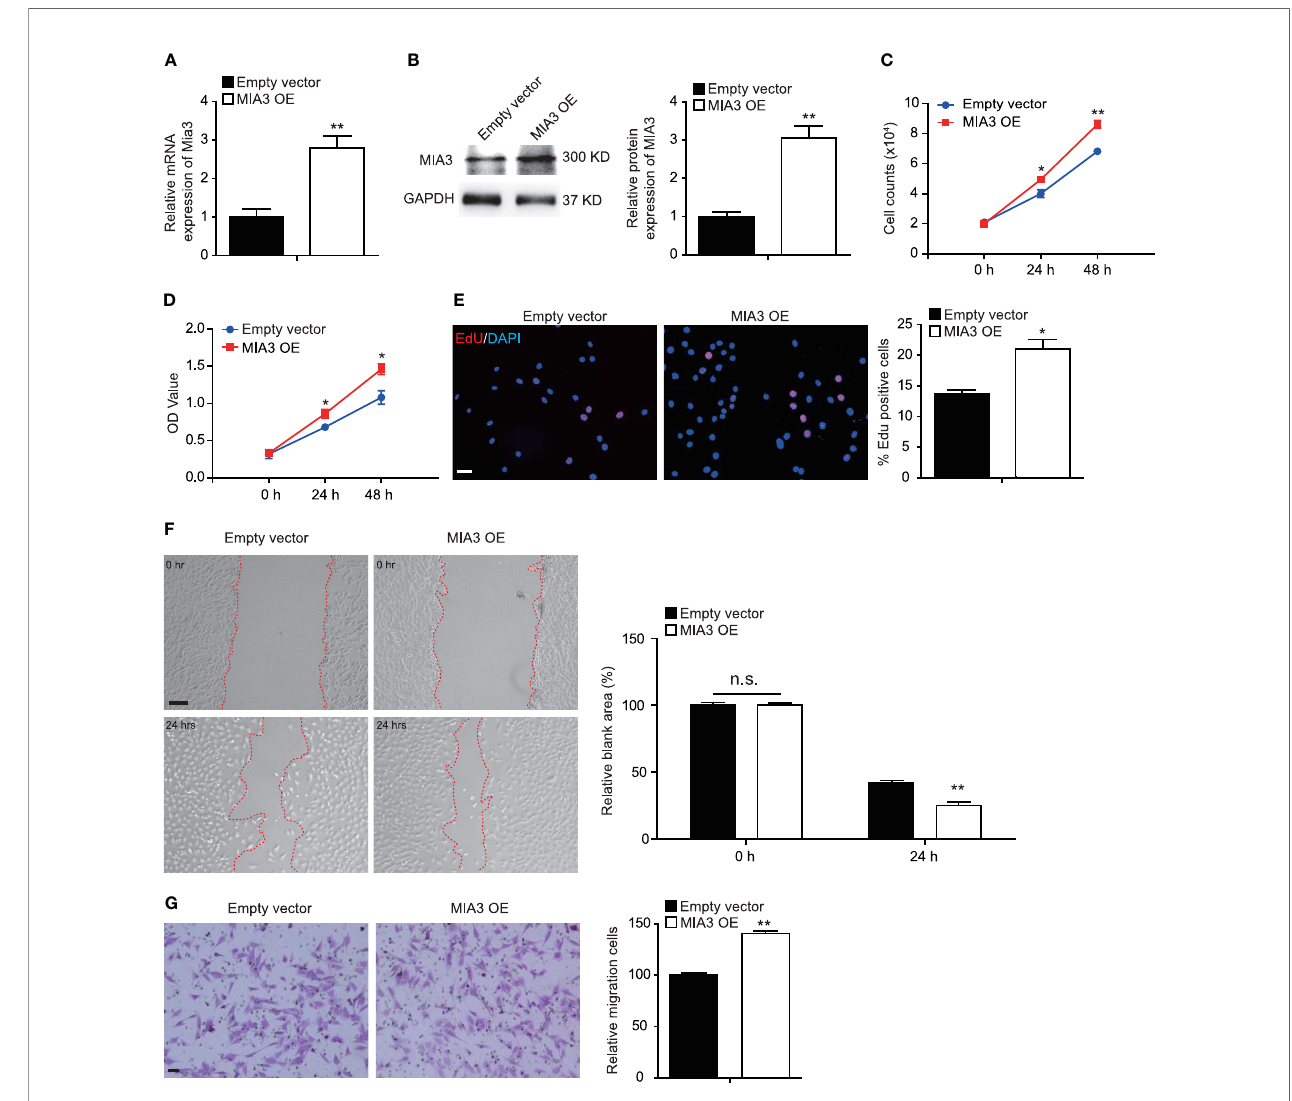
FIGURE 4 | MIA3 overexpression promotes vascular smooth muscle cell (VSMC) proliferation and migration. (A) MIA3 mRNA levels in human aortic smooth muscle cells (HASMCs) transfected with MIA3 overexpressing vector (OE) and control empty vector. Data are represented as the mean ± SEM, n = 3. ** p < 0.01, t -test. (B) MIA3 protein levels in human aortic smooth muscle cells (HASMCs) transfected with MIA3 overexpressing vector and control empty vector with quantitative data on the right. GAPDH served as loading control expression. Data are represented as the mean ± SEM, n = 3. * p < 0.05, t -test. (C, D) VSMC proliferation was determined by cell counts (C) and 3-[4,5-dimethylthiazol-2-yl]-2,5 diphenyl tetrazolium bromide (MTT) assay (D) in VSMCs with or without transfection of MIA3 overexpressing vector. All data were indicated as the means ± SEM, n = 3. ** p < 0.01, t -test. (E) VSMC proliferation was determined by 5- ethynyl-2 ’ -deoxyuridine (EdU) incorporation in VSMCs with or without transfection of MIA3 overexpressing vector. Percentage of EdU staining – positive cells was quanti fi ed on the right. Scale bar: 50 m m. Data are represented as the mean ± SEM, n = 3. ** p < 0.01, t -test. (F) The wound-induced cell migration assay was performed in VSMCs with or without transfection of MIA3 overexpressing vector. The relative blank wound areas in the left were quanti fi ed on the right. Scale bar: 100 m m. Data are represented as the mean ± SEM, n = 3. n.s. indicates nonsigni fi cant. ** p < 0.01, t -test. (G) The transwell assay in VSMCs transfected with MIA3 overexpressing vector or empty vector. The transferred and stained cells were counted on the right. Scale bar: 50 m m. Data are represented as the mean ± SEM, n = 3. ** p < 0.01, t